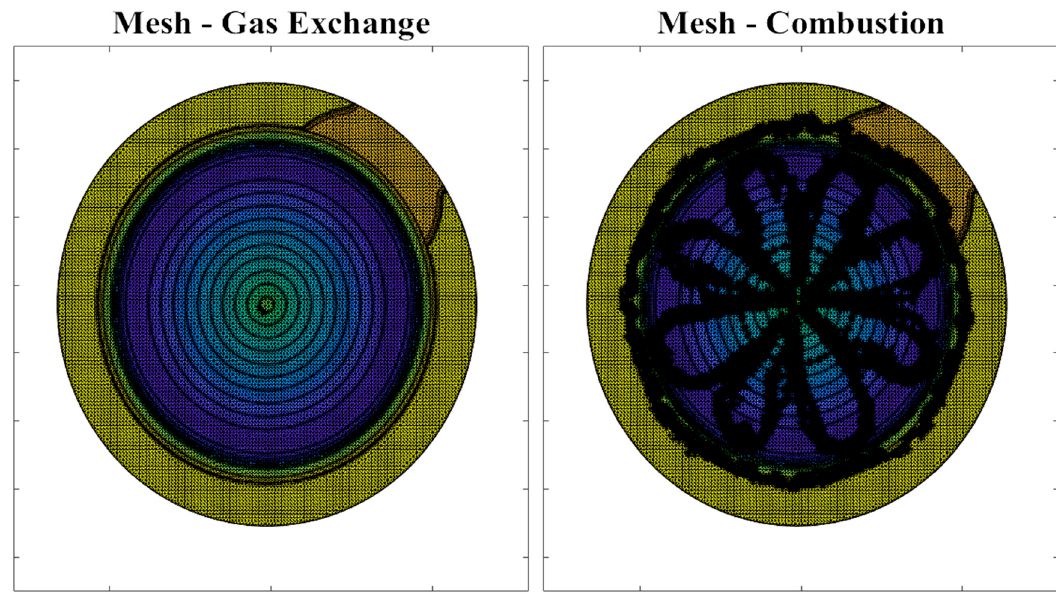
Figure 2. Adaptive mesh refinement impacts on mesh density as shown for lowest vs. highest mesh density.